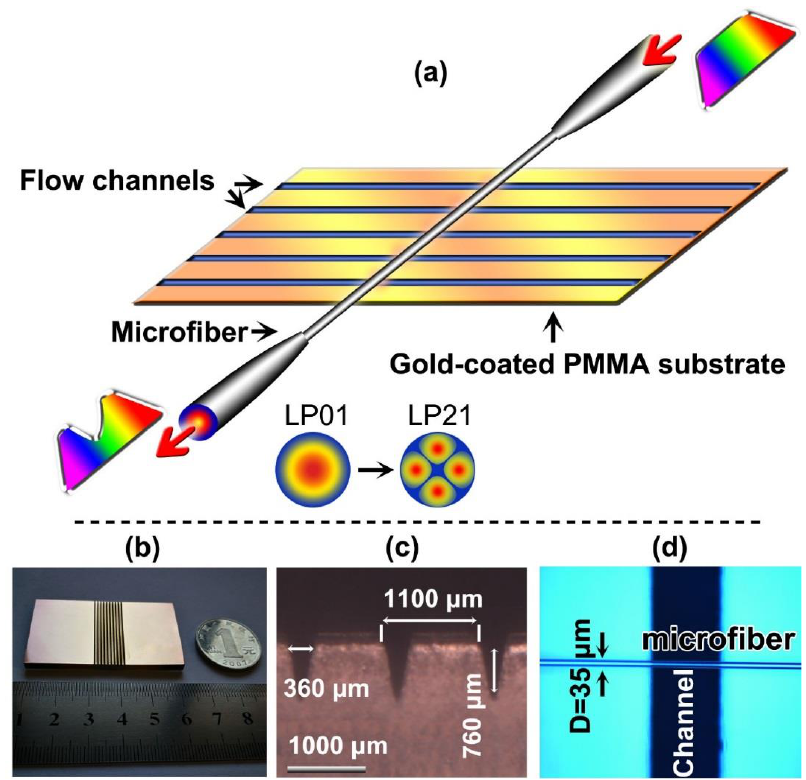
Figure 1. ( a ) Diagrams of the schematic of the VIOLIN sensor; Inset: the coupling between the two modes as indicated. ( b ) Real product of the substrate. ( c ) Scanning electron microscopic (SEM) image of the fluidic channel (horizontal view). ( d ) The optical microscopic image of the microfiber vertically placed on the substrate (perpendicular view).